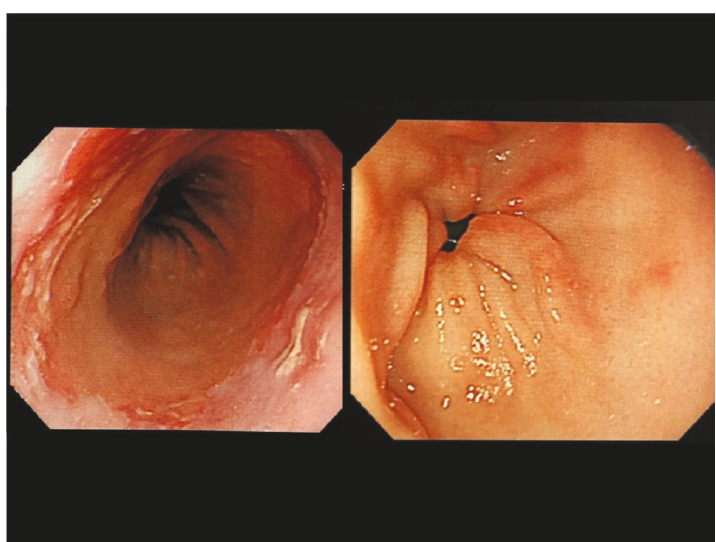
Figure 3: Esophagogastroduodenoscopy on the 15 th hospital day. Esophagogastroduodenoscopy revealed an esophageal erosion (left) and superficial gastritis